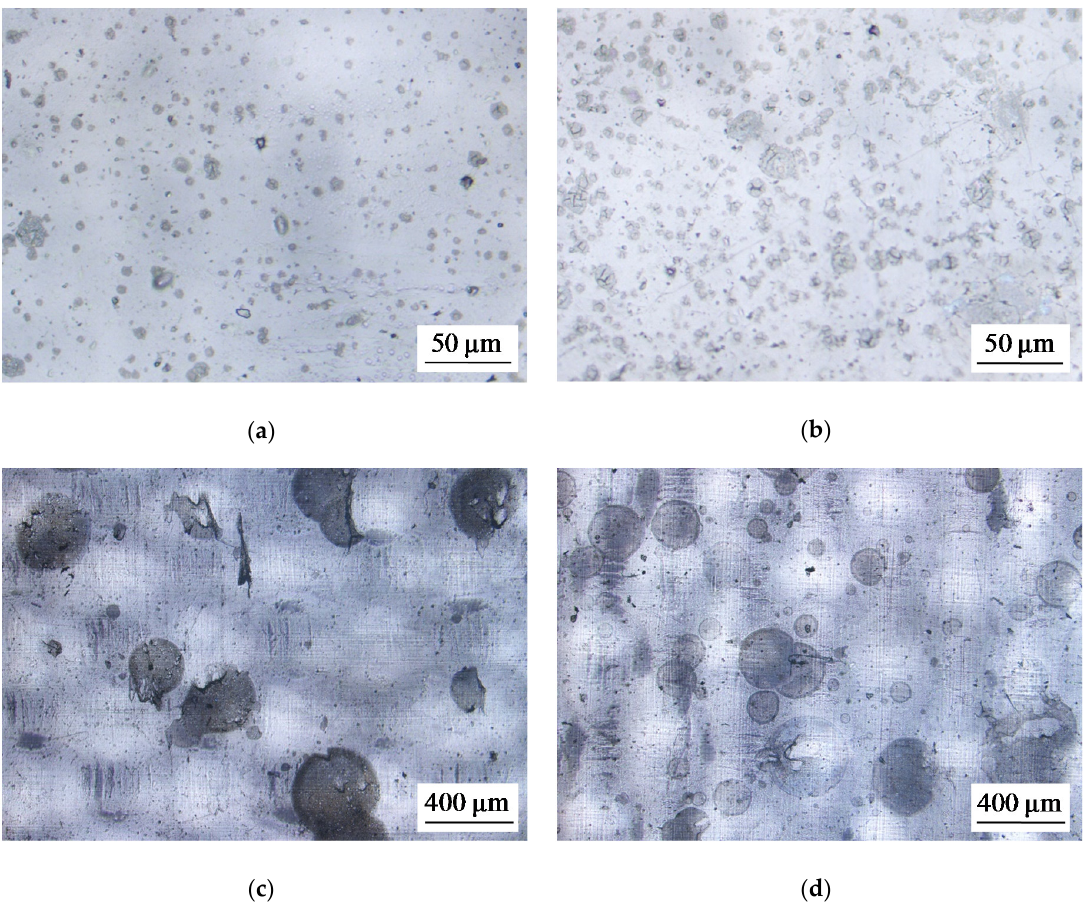
Figure 3. Optical images of the surface of swollen membrane samples: the modified AMX 1 ( a ), AMX 4 ( b ), AMX 2 ( c ), and AMX 3 ( d ) membranes.